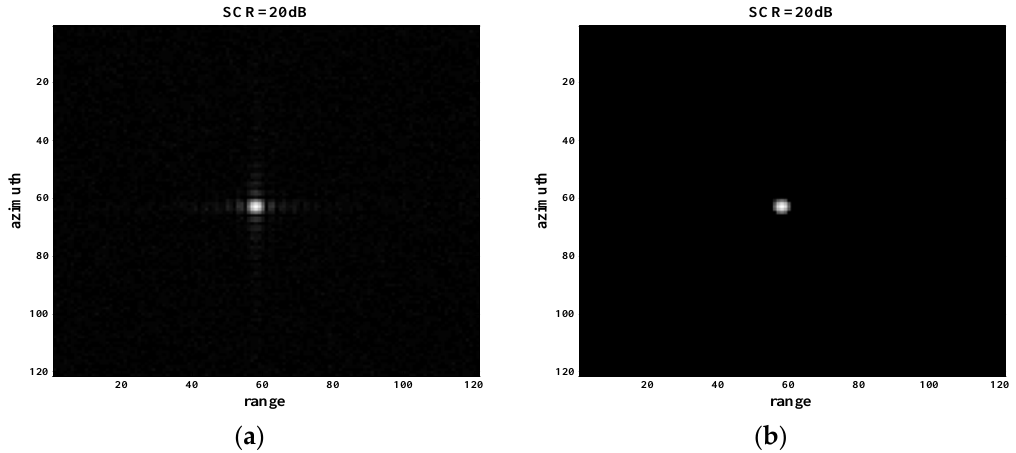
Figure 6. Experiment of single point target with SCR = 20 dB. ( a ) Original SAR image of single point target with SCR = 20 dB; ( b ) processed image of (a) through the proposed method. Sensors 2018 , 18 , x FOR PEER REVIEW